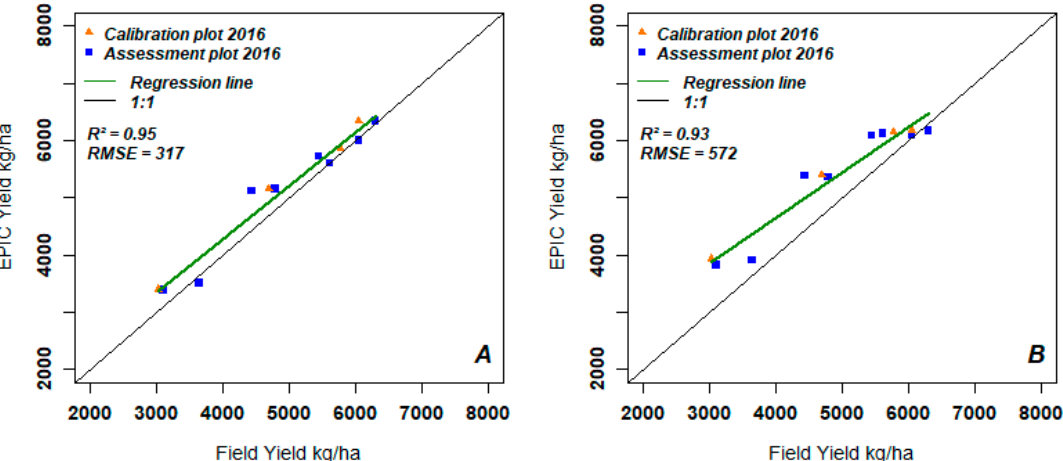
Figure 6. Yield estimation with ( A ) and without ( B ) the assimilation of LAI from Sentinel-2 data. The orange triangles are the plot used for the calibration of fmincon and the EPIC unknown parameters, and the blue square symbols represent plots used for the assessment only.